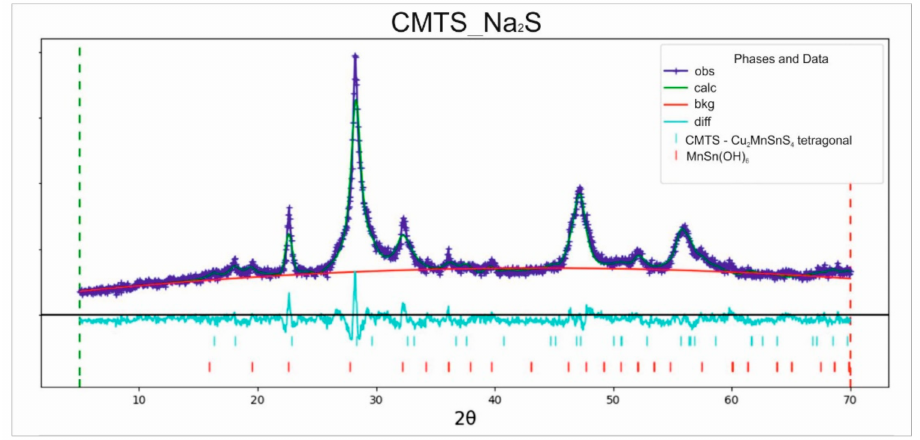
Figure 1. Refined XRD pattern of CMTS_Na 2 S consisting of tetragonal Cu 2 MnSnS 4 with a small admixture of MnSn(OH) 6 (data residual wR =